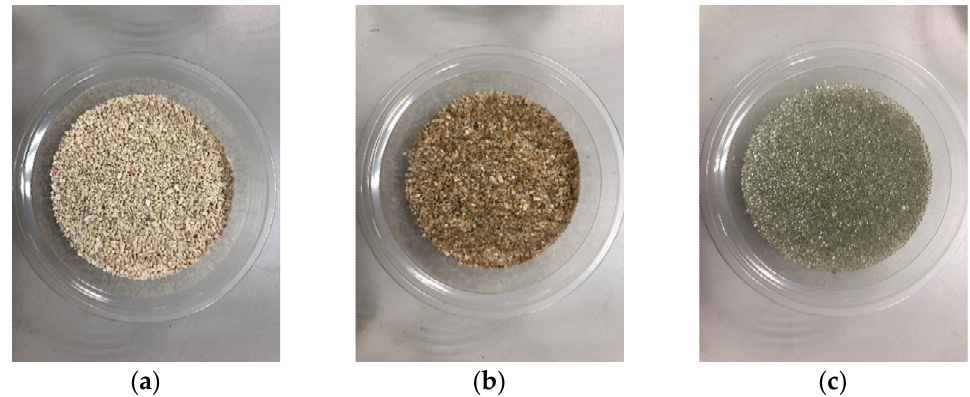
Figure 1. Photographs of the tested materials: ( a ) Calcareous sand; ( b ) Quartz sand; ( c ) Glass bead.